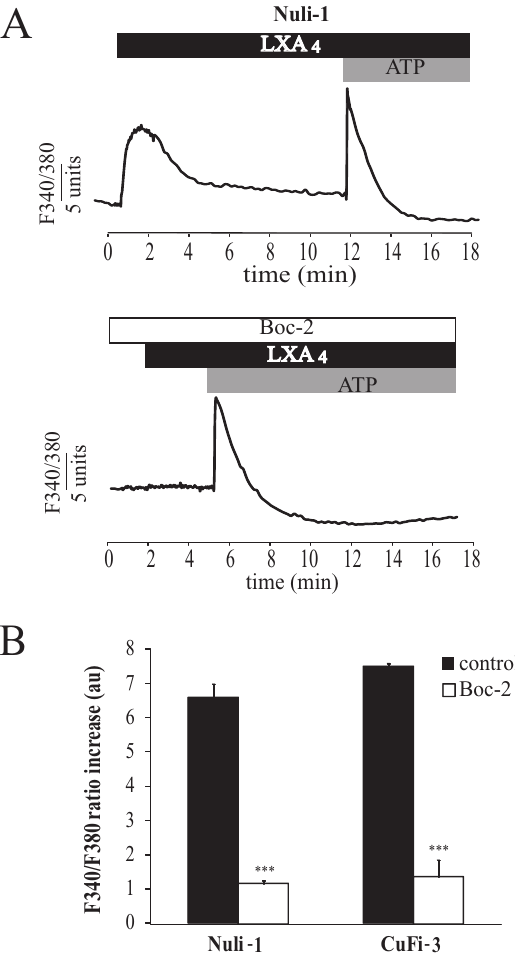
Figure 2. Effect of Boc-2 on the intracellular Ca 2 + signal induced by LXA 4 . (A) Representative effect of LXA 4 (100 nM) and ATP (100 m M) on cytosolic Ca 2 + (ratio F340/F380) in NuLi-1 cells in control conditions (upper panel) and after 24 hours of pre-treatment with Boc-2 (10 m M) a specific inhibitor of ALX/FPR2 (lower panel). (B) Mean values corresponding to the effect of Boc-2 on the Ca 2 + response to LXA 4 in Nuli-1 (n=5) and in CuFi-3 (n=4) cell lines (*** p , 0.001).